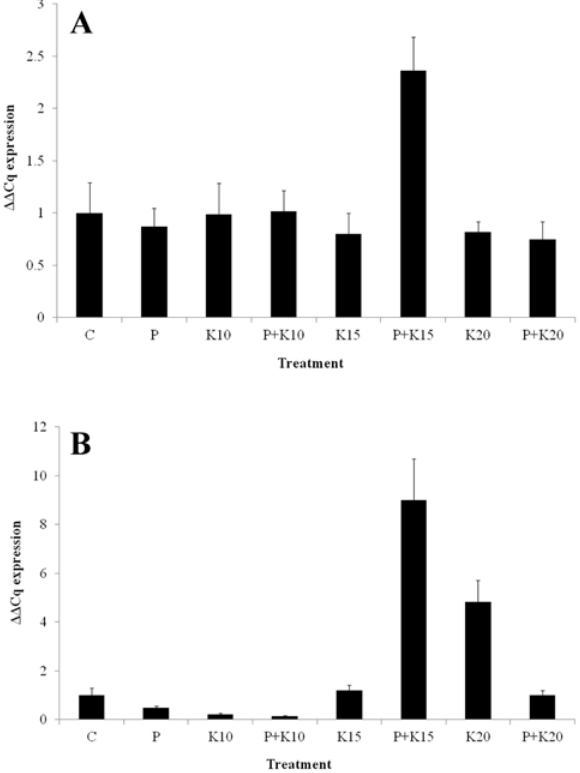
Figure 5. Gene expression using qRT-PCR of chitinases(A) and thaumatin-like proteins(B) in maize plants infected with R. solani and/or treated with khella extract at 10, 15 or 20%. C = control, P = pathogen, and K = khella